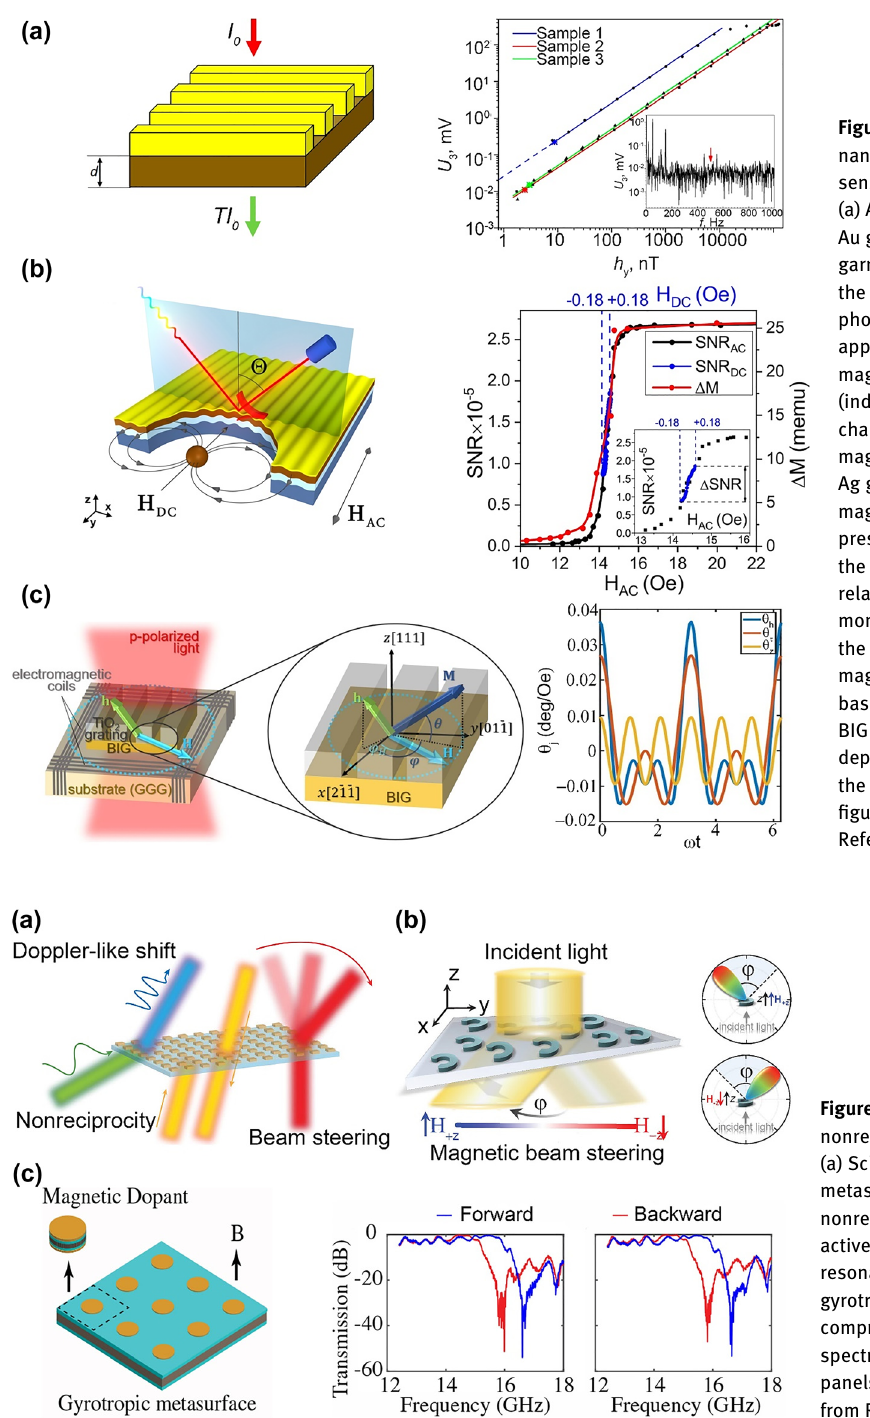
Figure 10: Applications of magneto- nanophotonic devices for magnetic field sensing.